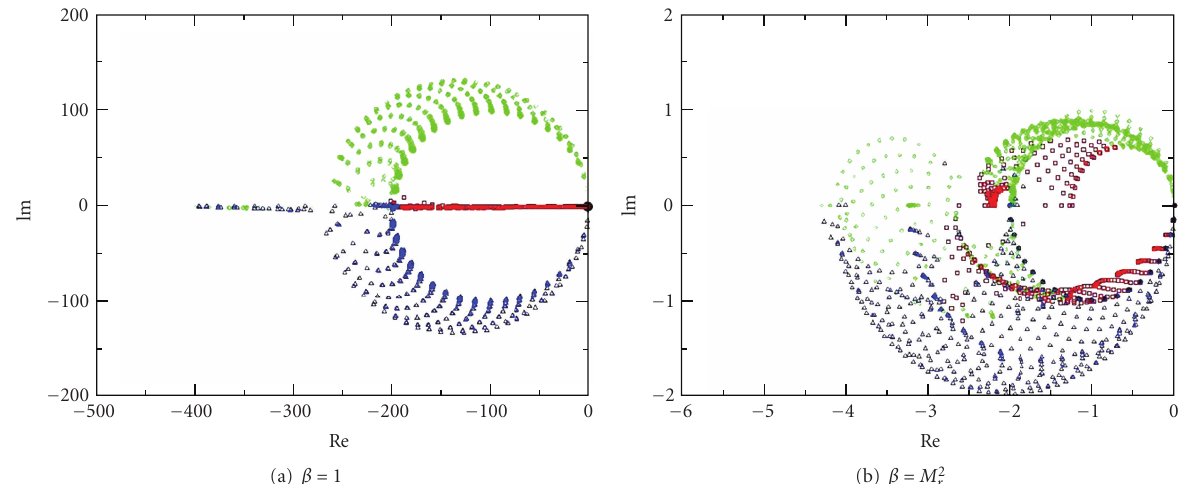
Figure 1: Fourier footprint of Euler operator for nonrotating flow ( M r = 0 . 01).